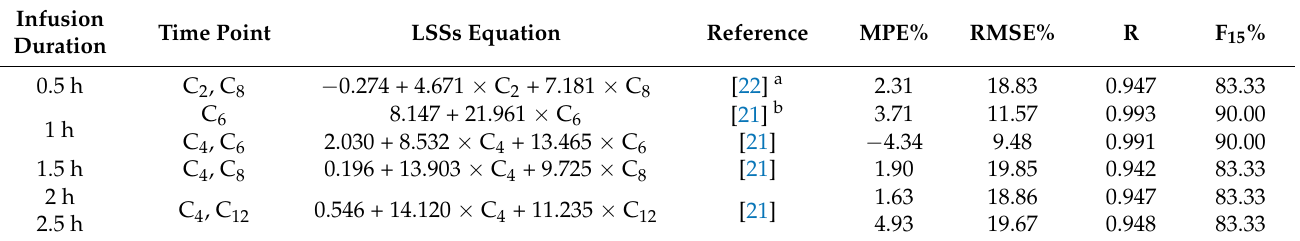
Table 4. Predictive performance of PMB LSSs from the published literature which was validated in our center and LSSs recommended for routine clinical